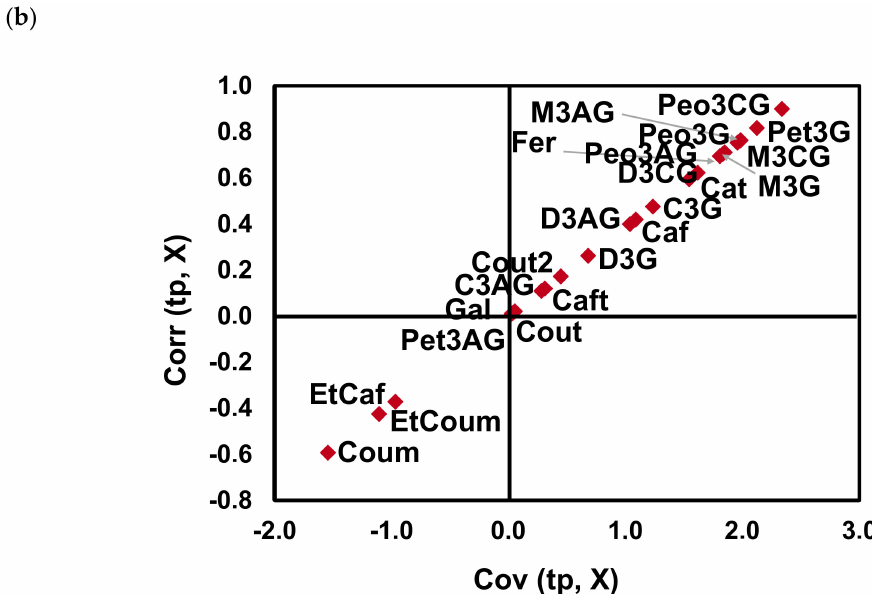
Figure 5. OPLS-DA (Orthogonal Partial Least Squares Discriminant Analysis) score plot for ‘Menc í a’ / ‘Jaen’ monovarietal wines from Bierzo D.O. and D ã o D.O. ( a ) and S-Plot for visualization of the variable influence on the OPLS-DA model by representing the covariance (Cov) and correlation (Corr) loading profiles resulting from the projection on the predictive component, tp ( b ). Delphinidin-3-glucoside (D3G), cyanidin-3-glucoside (C3G), peonidin-3-glucoside (Peo3G), petunidin-3-glucoside (Pet3G), malvidin-3-glucoside (M3G), delphinidin-3-acetylglucoside (D3AG), cyanidin-3-acetylglucoside (C3AG), peonidin-3-acetylglucoside (Peo3AG), petunidin-3-acetylglucoside (Pet3AG), malvidin-3-acetylglucoside (M3AG), delphinidin-3-coumaroylglucoside (D3CG), peonidin-3-coumaroylglucoside (Peo3CG), malvidin-3-coumaroylglucoside (M3CG), gallic acid (Gal), caftaric acid (Caft), coutaric acid (Cout), coutaric acid isomer (Cout2), caffeic acid (Caf), coumaric acid (Coum), catechin (Cat), ethyl ester of caffeic acid (EtCaf), ethyl ester of coumaric acid